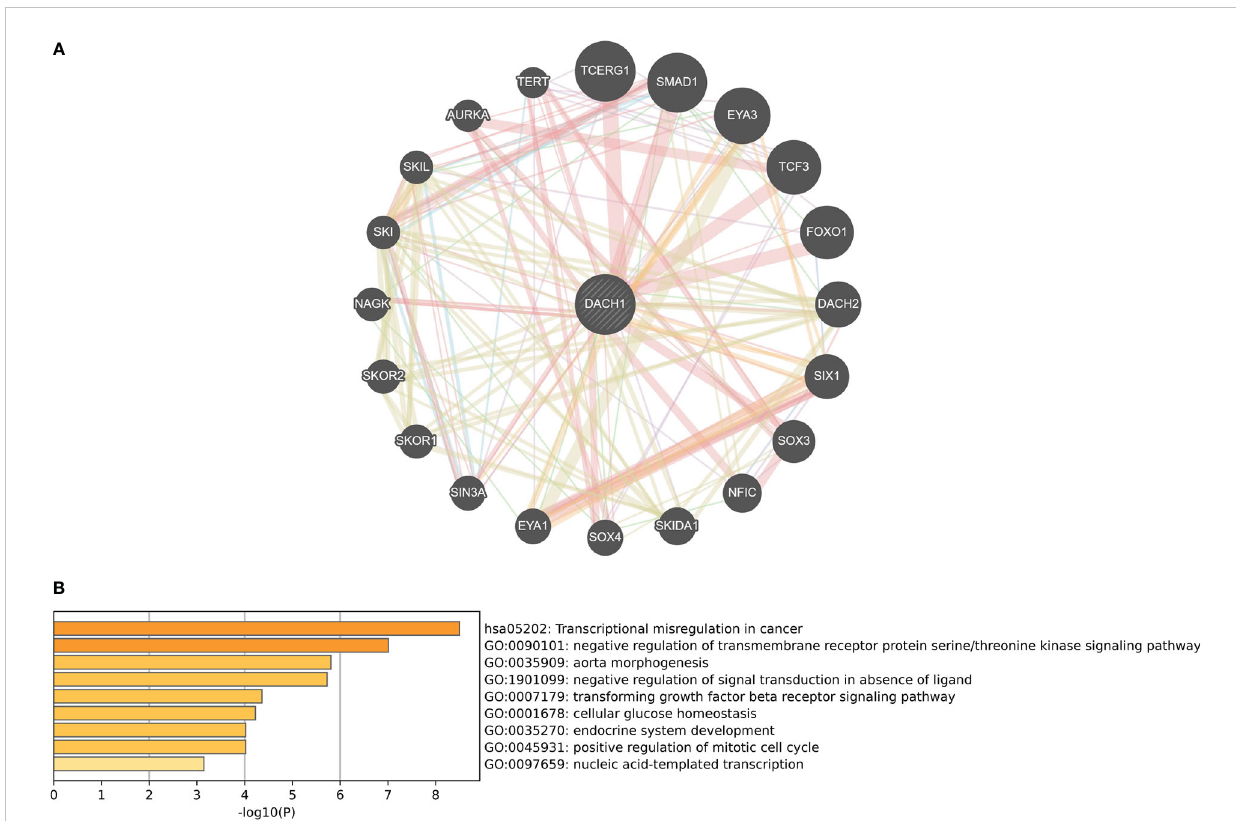
FIGURE 5 (A) Twenty genes that interact with DACH1 were identi fi ed on the GeneMANIA website. (B) Genes interacting with DACH1 were enriched for functions such as transcriptional misregulation in cancer, TGF-beta receptor signaling pathway, and negative regulation of signal transduction in absence of ligand.